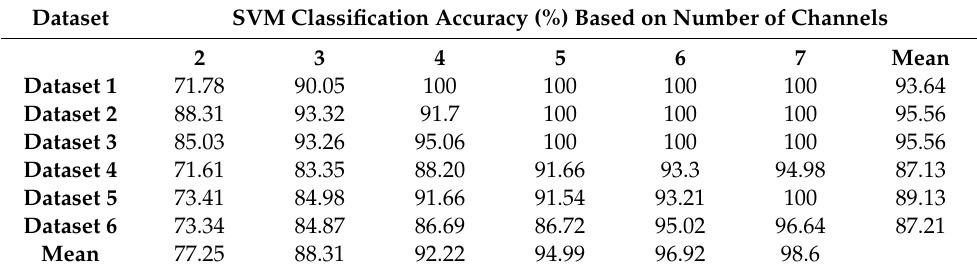
Table 5. Comparison support vector machine (SVM) classification accuracy for di ff erent datasets based on the number of